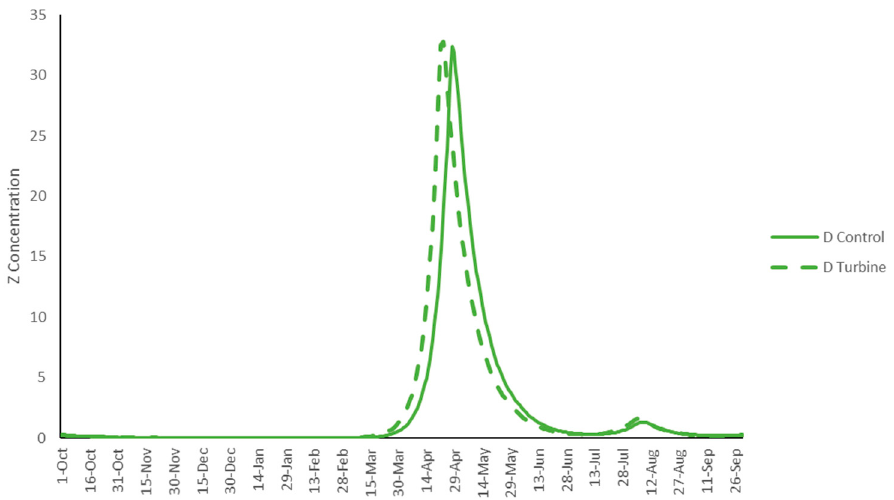
Figure 8. Annual variation in zooplankton concentration in the basin under PAR scenario D (Figure 4).